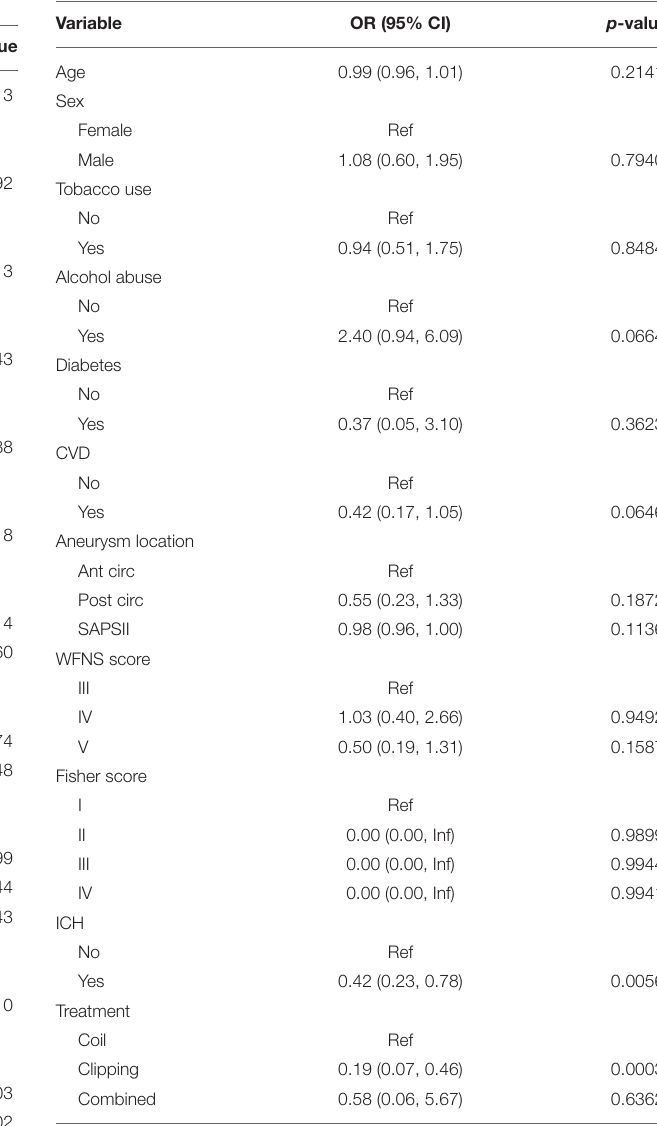
TABLE 3 | Univariate logistic regression analysis of risk factors for